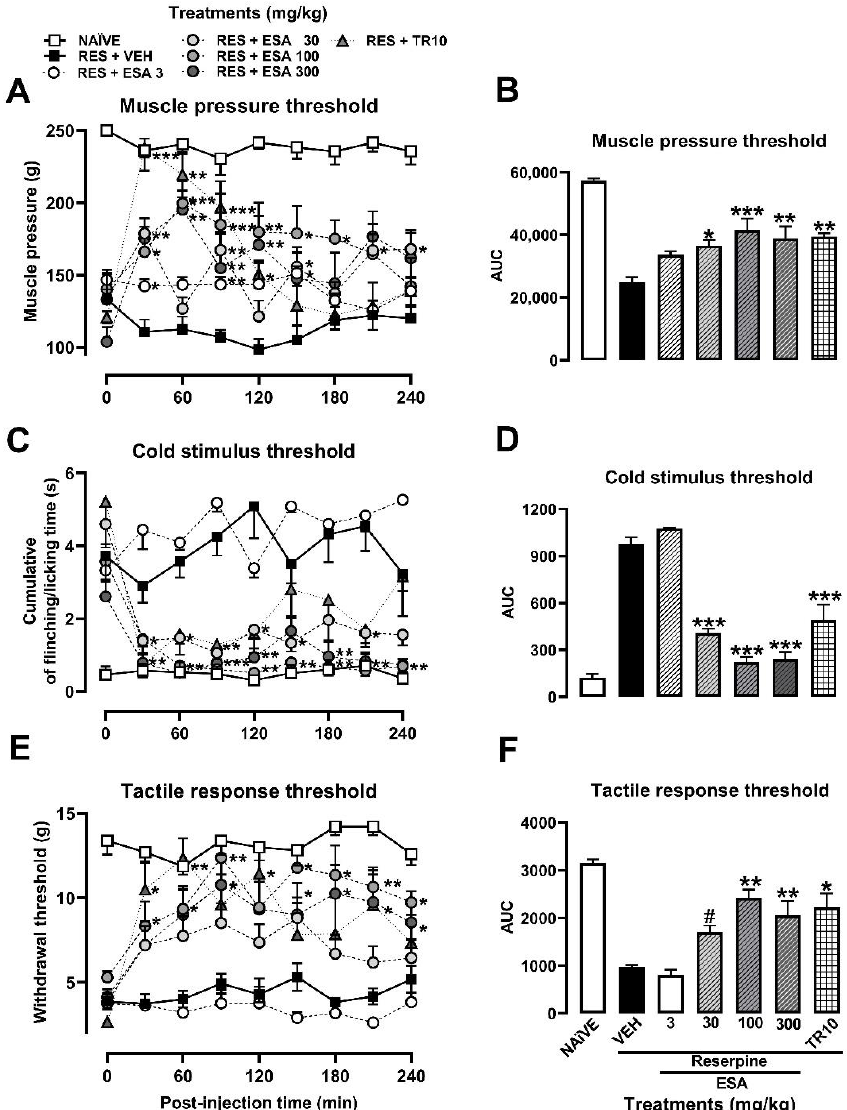
Figure 3. Antihyperalgesic and antiallodynic effect of S. amarissima EtOAc extract (ESA) on reserpine (RES)-induced fibromyalgia. ( A ) Muscle pressure threshold, ( C ) cold allodynia threshold, and ( E ) tactile response threshold on the 5th day post-induction. Each point represents the mean ± S.E.M of ( A ) the force in grams supported on the medial gastrocnemius muscle, ( C ) the accumulated response time to the cold stimulus (acetone) on the dorsal surface of the right hind limb for 1 min), ( E ) the force in grams supported on the plantar surface of the right hind limb (withdrawal threshold), compared to with the RES + VEH (reserpine, 1 mg/kg, s.c.), naïve and tramadol (TR10 mg/kg, i.p.) groups. Two-way repeated measures ANOVA followed by Dunnett´s post hoc test. * p